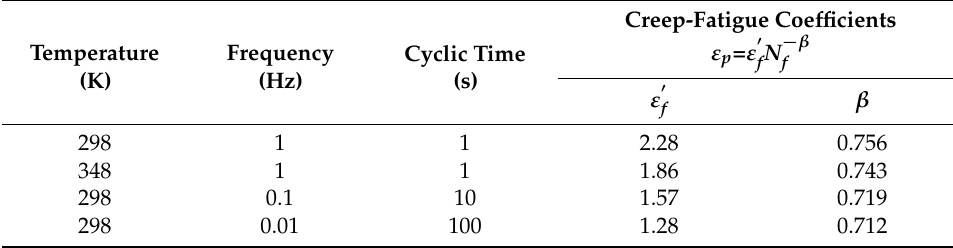
Table 3. Creep-fatigue data for 63Sn37Pb